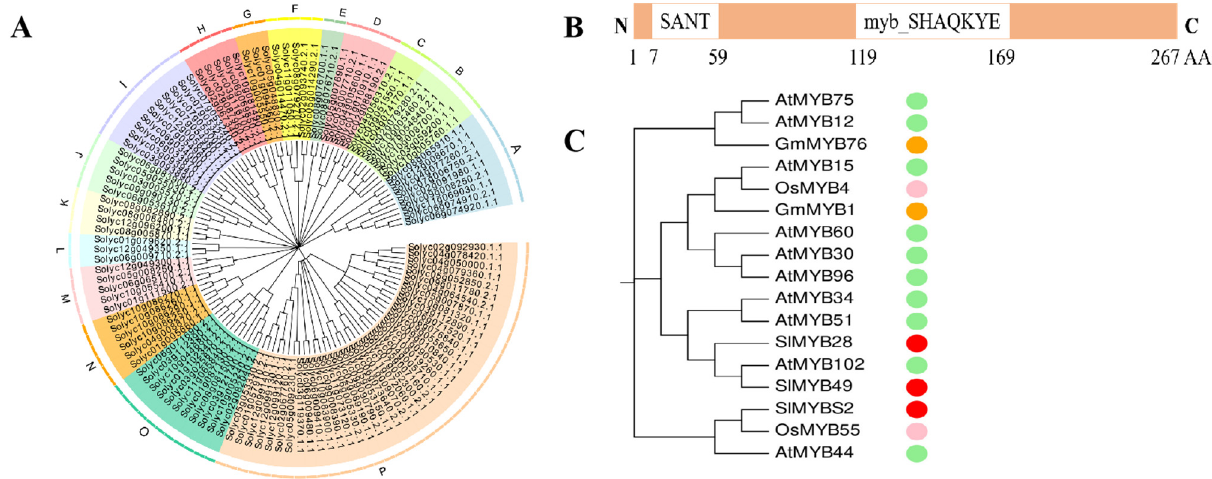
Figure 1. ( A ) Neighbor-joining (NJ) phylogenetic tree of SlR2R3MYB family genes. The unrooted phylogenetic tree from the complete protein sequence was depicted by the MEGA X program with the NJ method. The tree shows the 16 phylogenetic subgroups (A–P) with high bootstrap values. ( B ) Protein domain structure of SlMYBS2 . ( C ) Phylogenetic analysis of MYB homologs in different species. Red circle, tomato; green circle, Arabidopsis; pink circle, rice; orange circle, soybean.